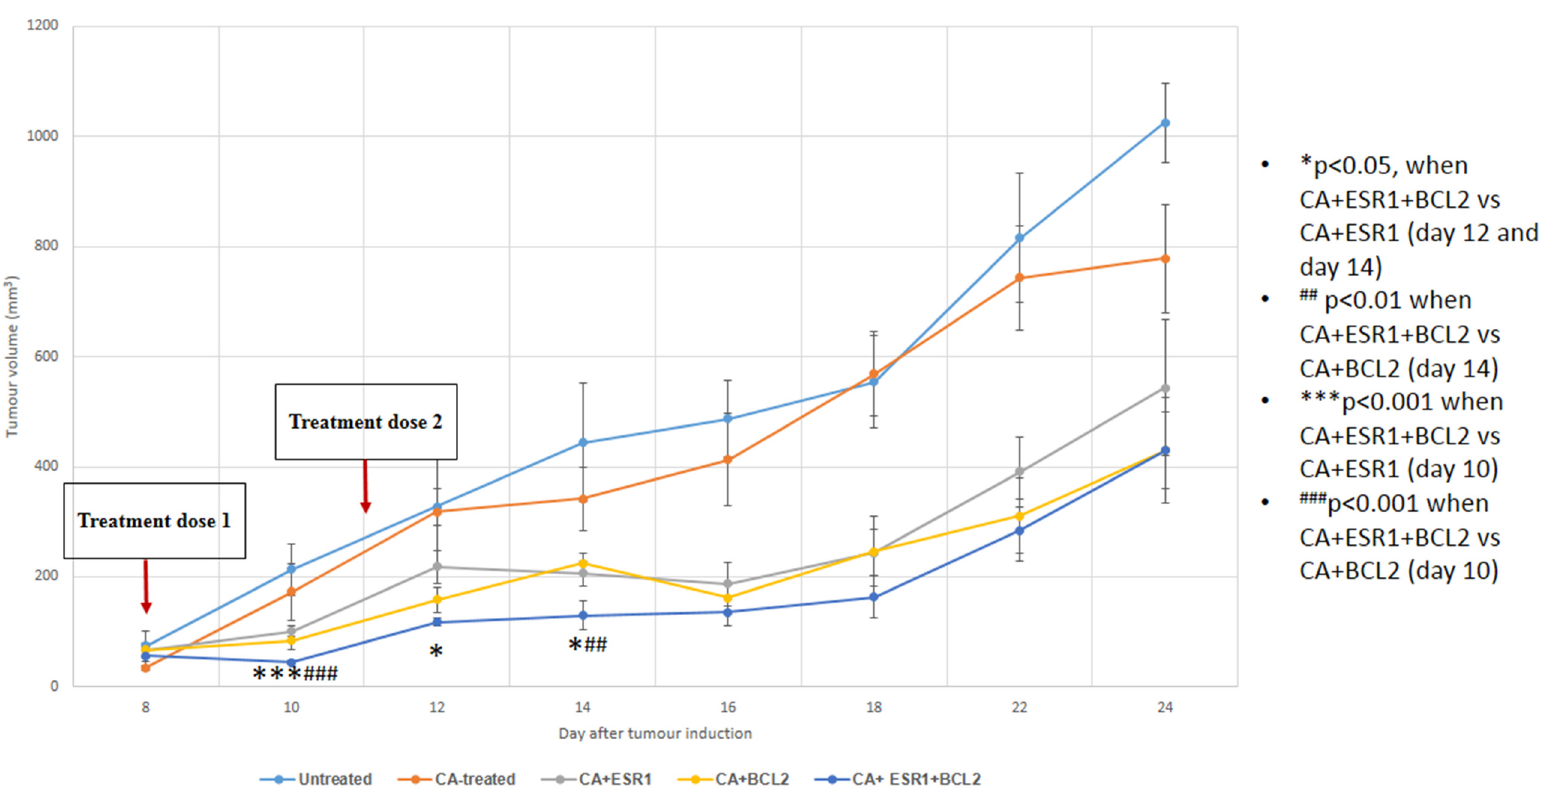
Figure 10. Tumor outgrowth volume of mice intravenously treated with CA+ESR1 siRNA, CA+BCL ‐ 2 siRNA and CA+ESR1+BCL ‐ 2 siRNA complexes on a 4T1 induced breast tumor mouse model. Mice were administered twice (three days apart) with 100 μ L of CA, CA+ESR1 siRNA, CA+BCL ‐ 2 siRNA and CA+ESR1+BCL ‐ 2 siRNA complexes. CA+siRNA complexes were formed by mixing 50 mM of a particular siRNA along with 4 μ L of 1 M CaCl 2 in 100 μ L of freshly prepared bicarbonated (44 mM) DMEM media and incubating at 37 °C for 30 min. Six mice per group were used and data was represented as mean±SD. Values were significant with * p < 0.05 compare to the control group.